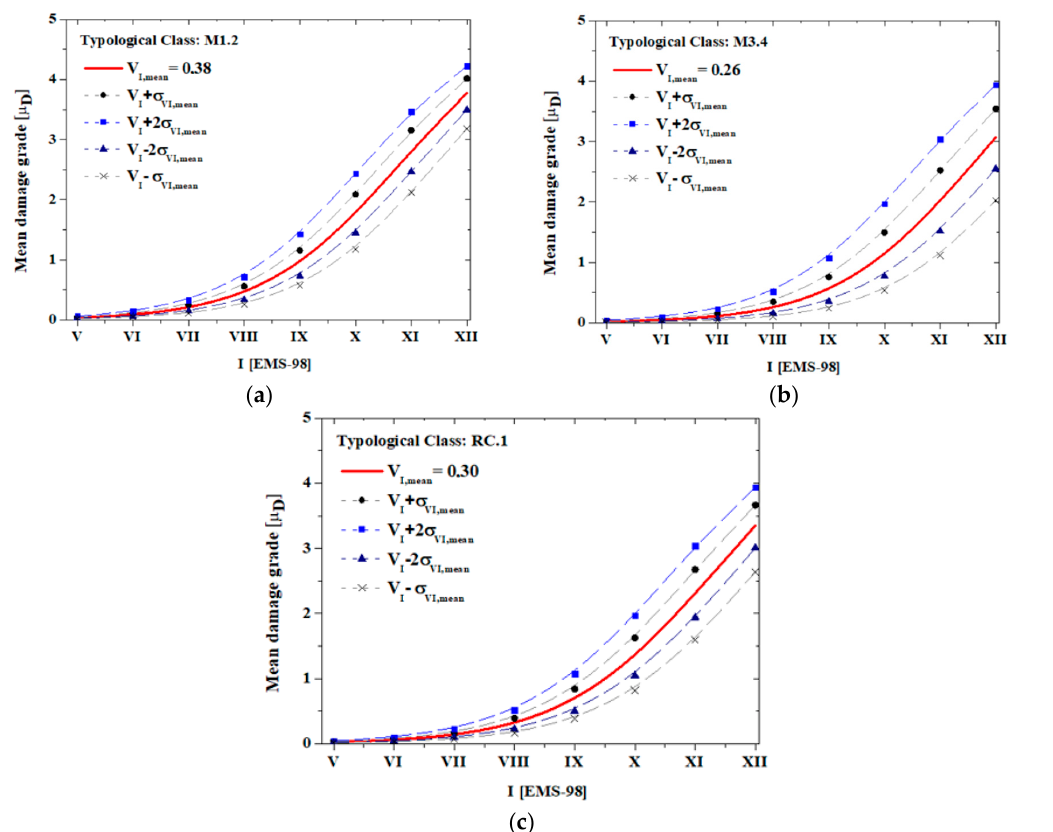
Figure 7. Mean vulnerability curves for building samples of ( a ) M1.2, ( b ) M3.4, and ( c ) RC.1 typological classes.